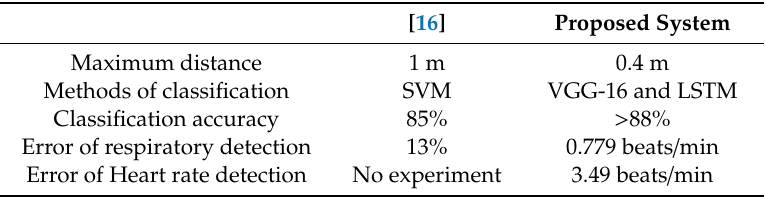
Table 3. The comparison between two